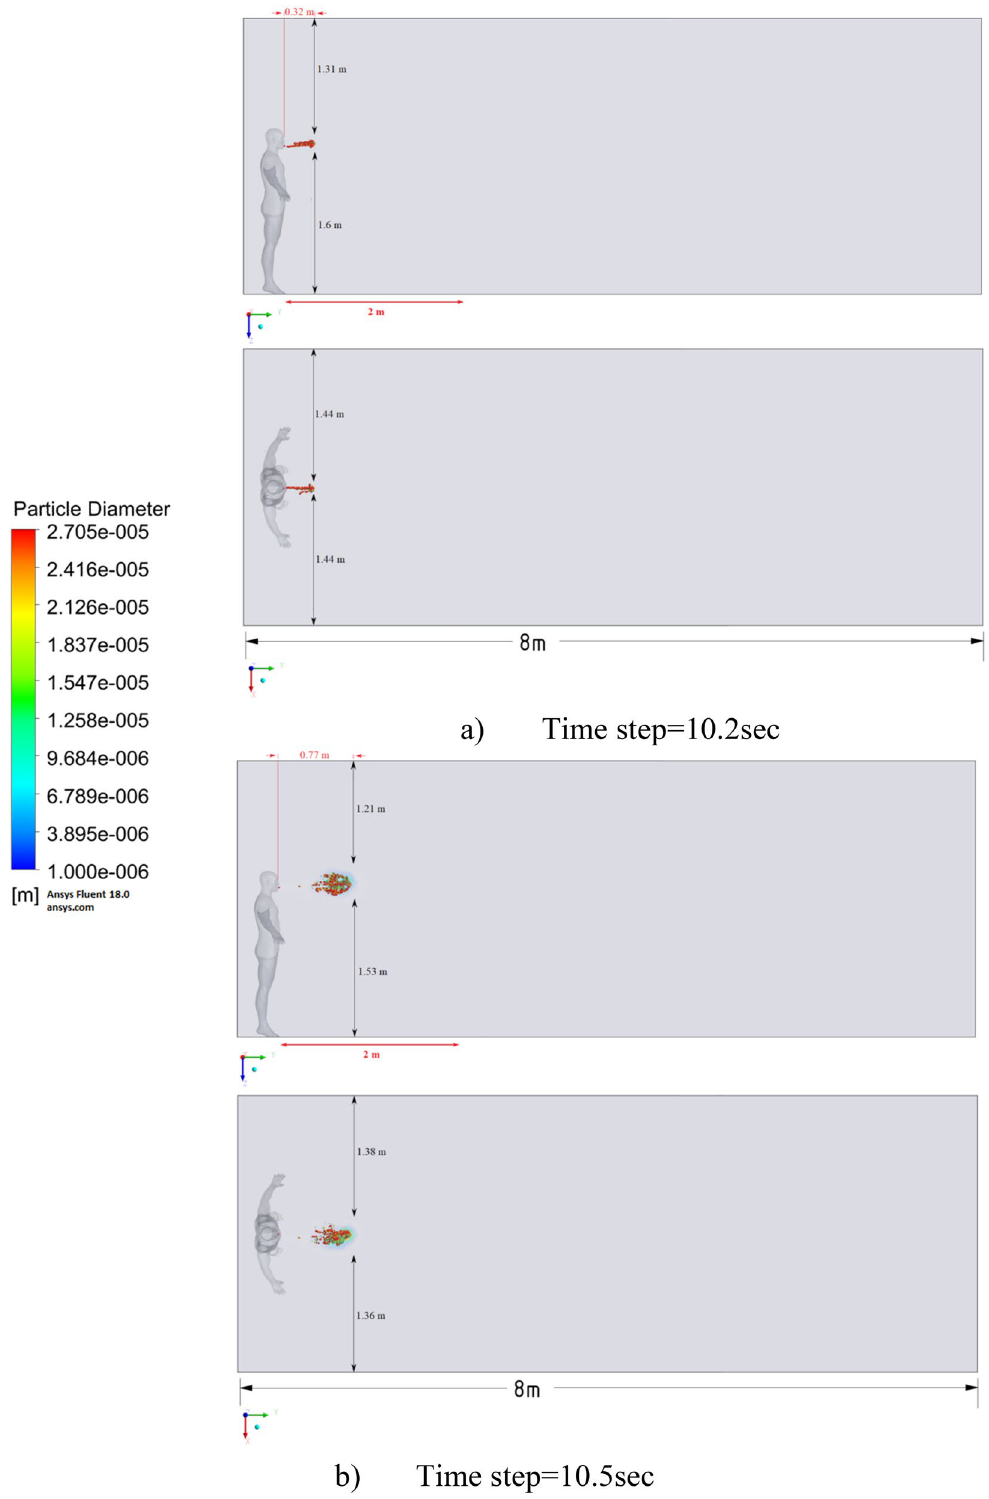
Figure 23. Distribution of the particles for cough = 20 m/s and ventilation = 1